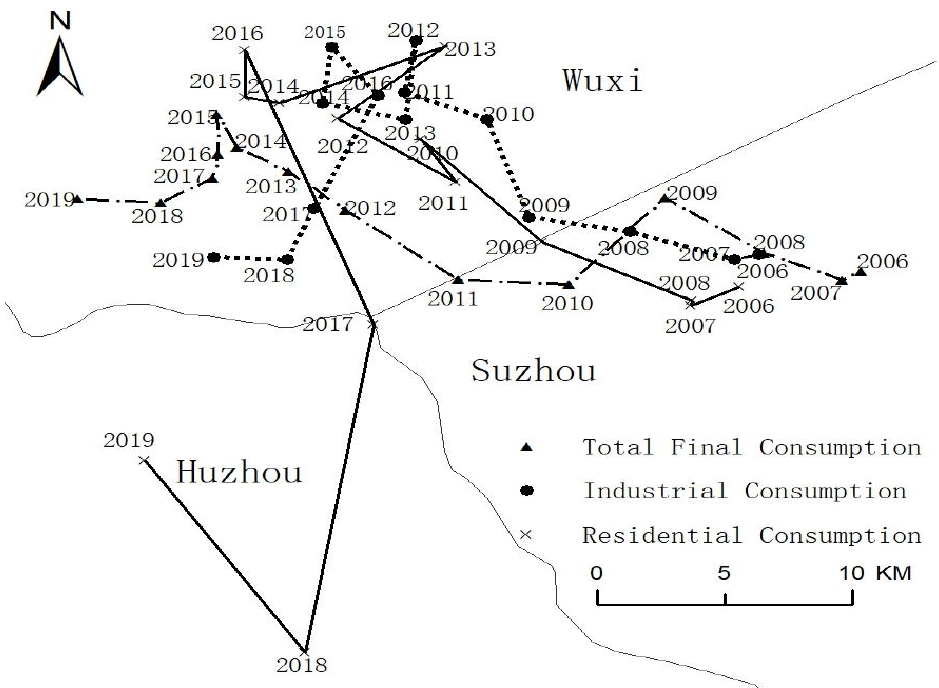
Figure 2. The movement of center of gravity for electricity consumption in the YRD region. Table 2. Location and moving distance of the center of gravity for electricity consumption (km).